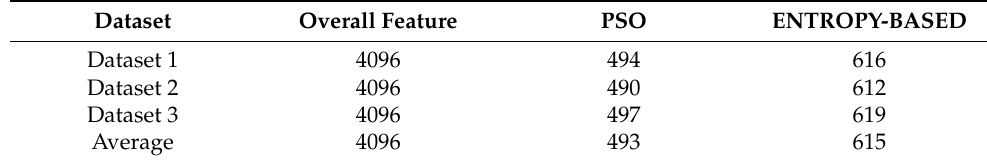
Table 12. Performance feature selection results.